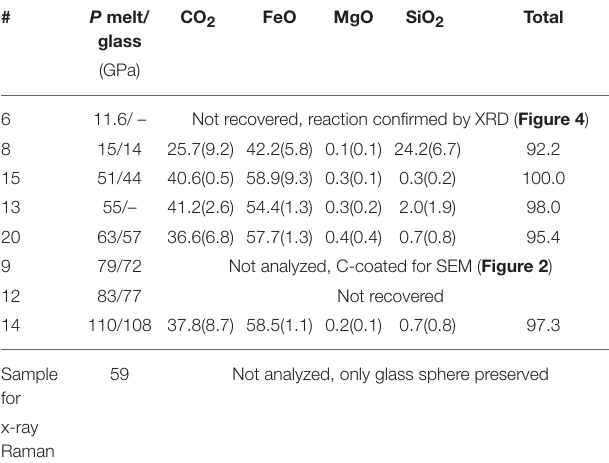
TABLE 1 | Run conditions, quenched products and their chemical composition in wt% obtained from EMPA. One standard deviations are given in parentheses. Starting natural siderite sample also contained < 0.1 wt% CaO and